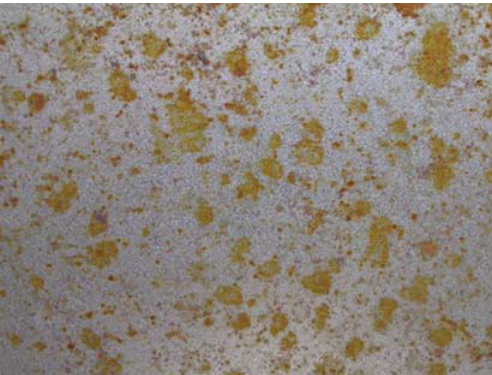
Figure 3: Appearance of the mild steel surface after one year of outdoor exposure in